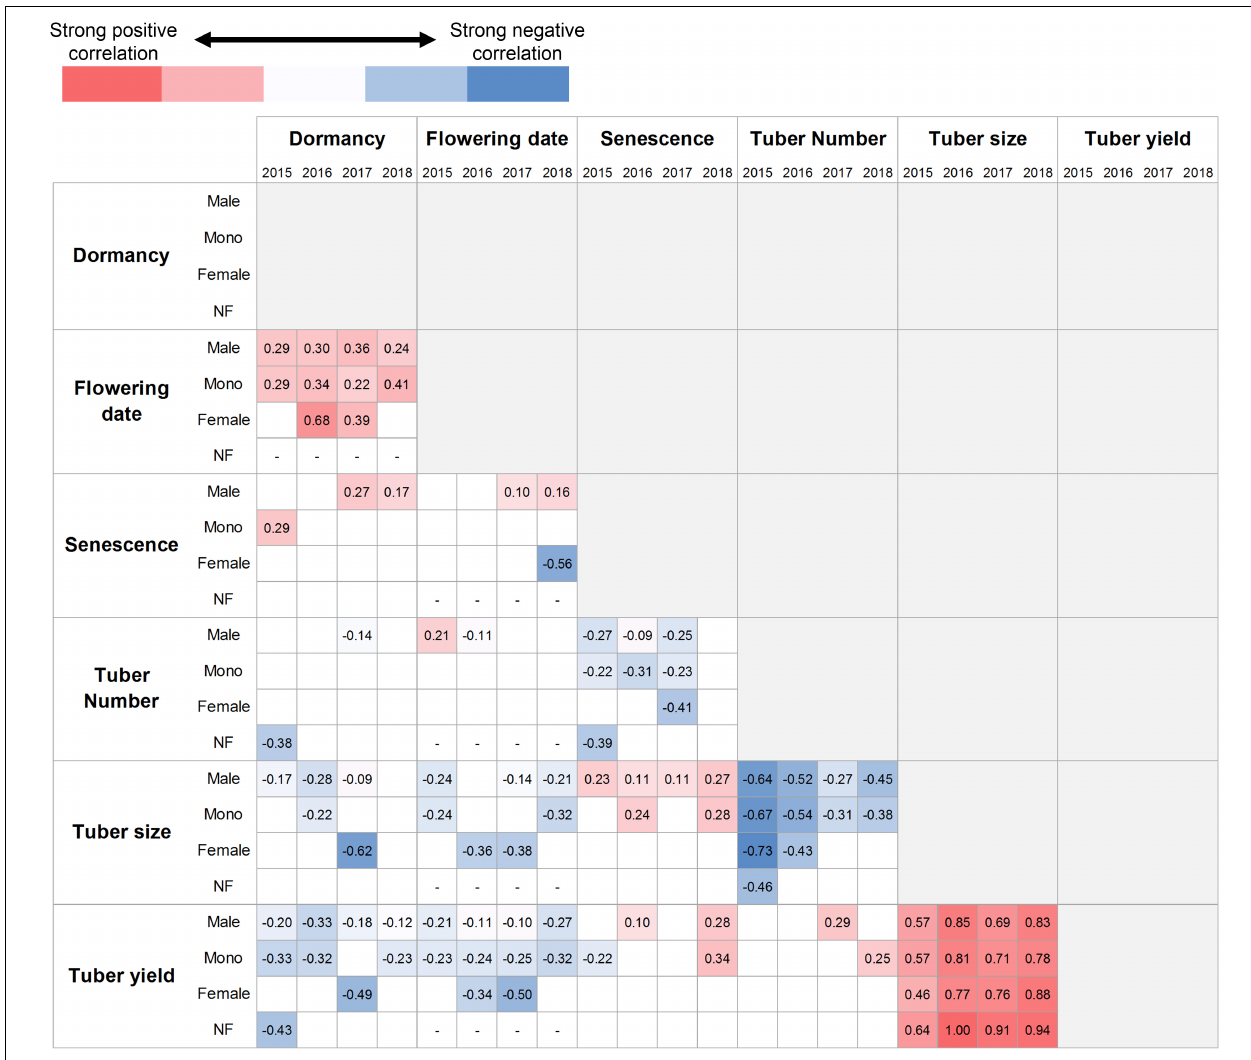
FIGURE 5 | Trait correlations among the F 1 population. Pearson’s correlation coefficient with statistical significance at P < 0.05 level is separately shown for sex phenotypes and years. "Mono" and “NF” denote the monoecious and non-flowering plants, respectively. The monoecious phenotype includes both the first and second types. The empty boxes indicate that the relationship is not significant. The sex phenotypes and years are indicated in rows and columns, respectively. The red and blue colors represent the positive and negative relationships; the deeper the color, the stronger the correlation. The number of plants analyzed in each box corresponds to Figure 3B